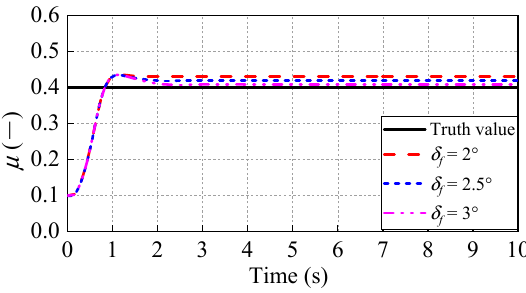
Figure 9. RFC estimated by ITM.